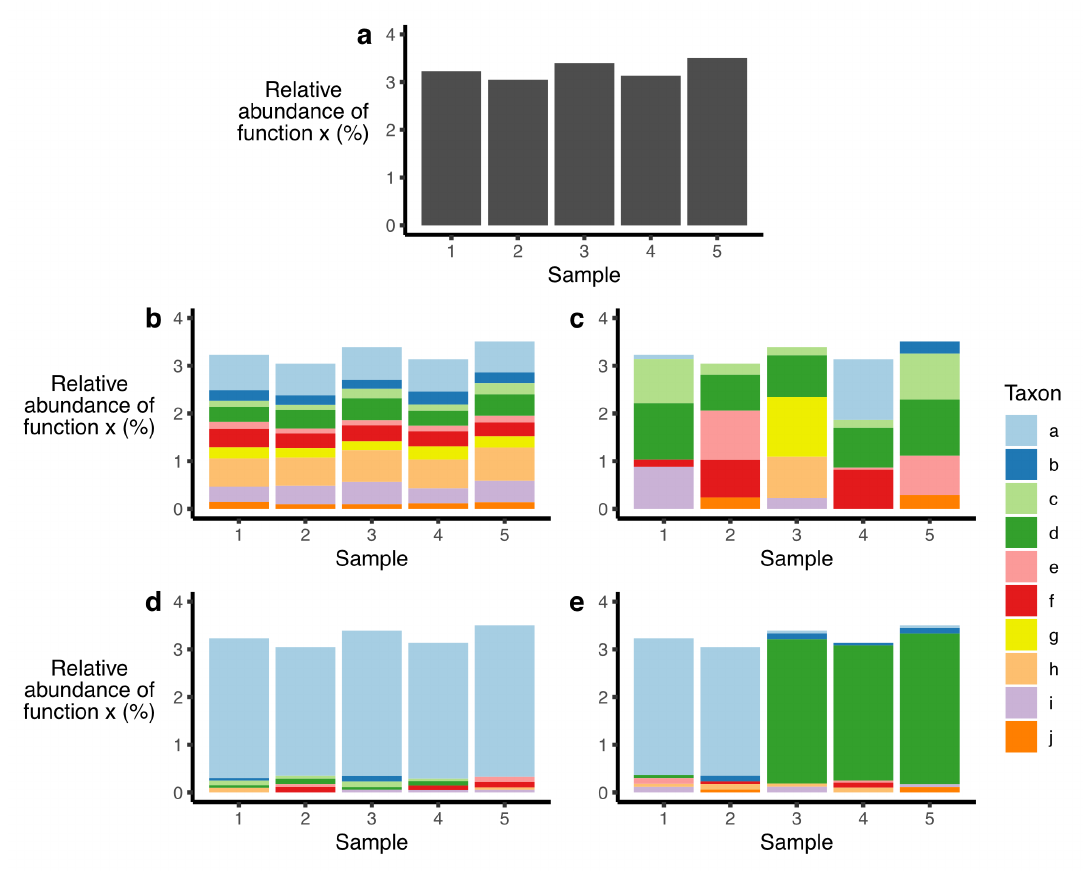
Figure 5: Contrasting extremes of taxa contributing to a function across samples . A simple example of relative abundances for a given microbial function (e.g., a pathway) across five samples, which is at similar levels across all samples. It is common to analyze microbial functions without integrating taxonomic information. However, including this taxonomic information can help distinguish many different biological scenarios. Panels b-e represent four extreme scenarios that could account for the relative abundances shown in panel a. These examples also highlight the value of using stacked bar charts and are closely based on the examples presented by Franzosa et al., 2018. The examples: (b) stable contribution of the function by the same diverse taxa; (c) contribution of the taxa by different taxa; (d) stable contribution primarily by a single taxon; and (e) contribution primarily by a single taxon, which can differ across